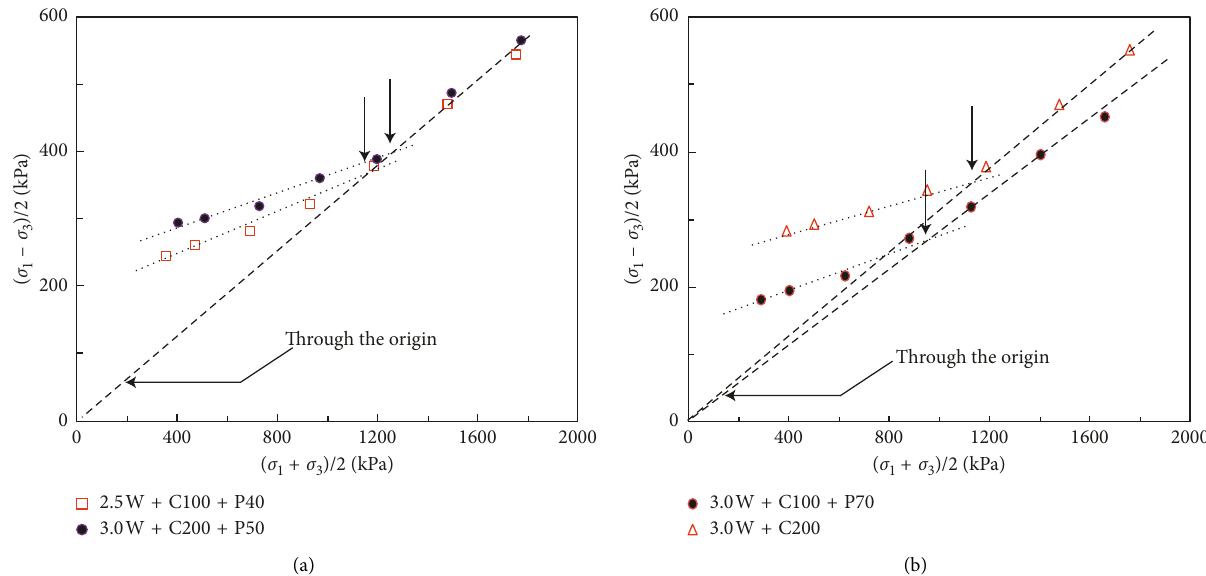
Figure 7: Undrained shear strength versus normal stress: (a) 2.5W+C100+P40 and 3.0W+C200+P50; (b) 3.0W+C100+P70 and 3.0W+C200.